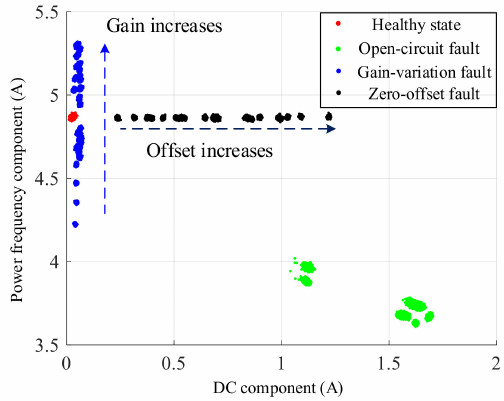
Figure 8. The distribution of faults under the DC and power frequency